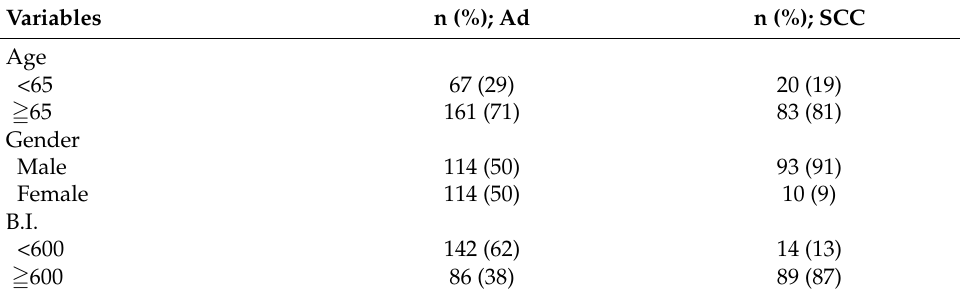
Table 1. The clinical data of